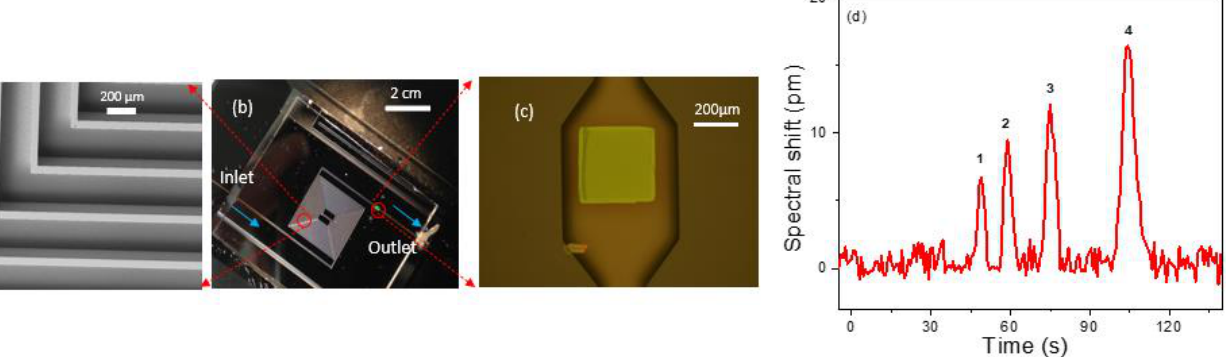
Figure 6. ( a ) Angled view SEM image of a Si column. ( b ) An image of the 3 m Si column bonded with glass with PCS (green dot) at the outlet of the column and blue arrow showing the flow direction. ( c ) Microscope image of the